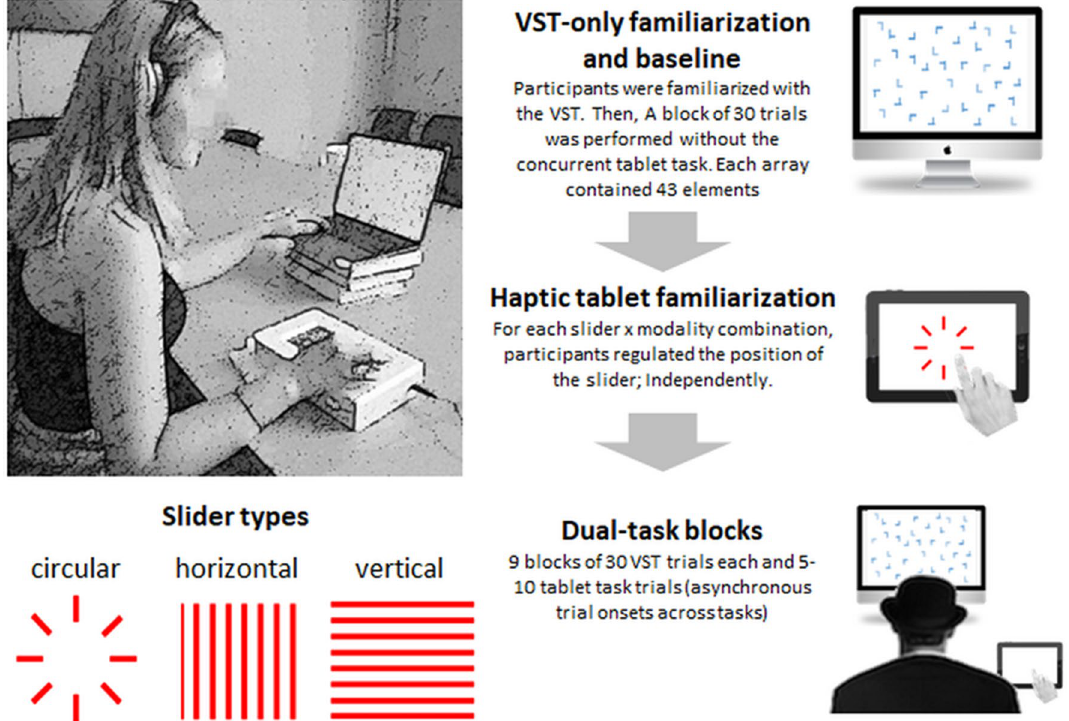
Figure 1. Overview and synopsis of the experimental paradigm. Participants simultaneously performed the central visual search task (VST) as well as a task on the haptic tablet that involved control of vertical, horizontal or circular sliders. These sliders were in turn presented either in a purely unisensory haptic, unisensory visual, or multisensory manner. The right side of the figure illustrates the sequence of familiarization and tasks performed by the